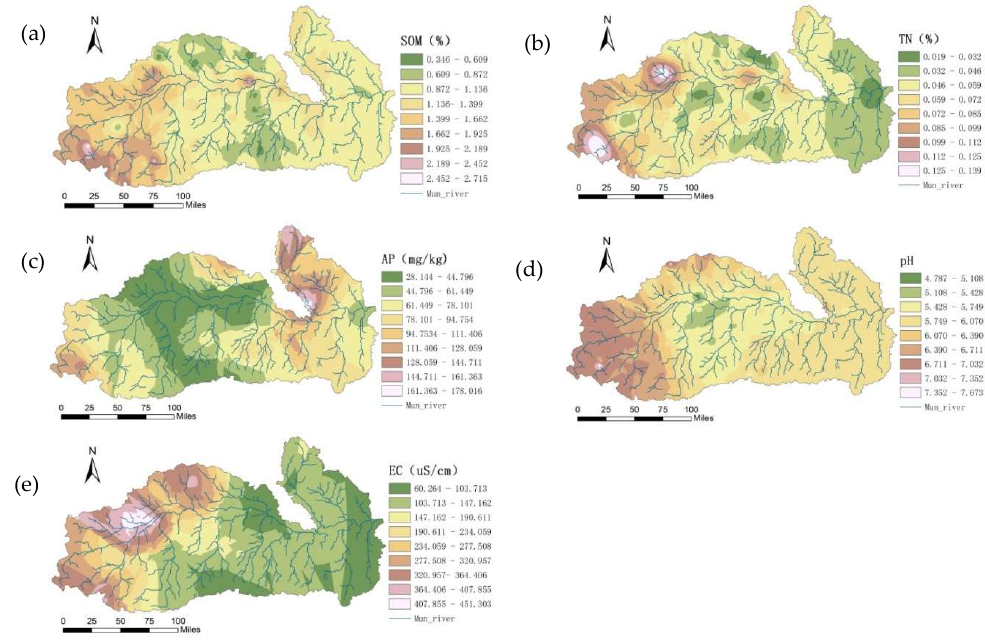
Figure 7. Spatial patterns of SOM ( a ), TN ( b ), AP ( c ), pH ( d ), and EC ( e ) in the dry